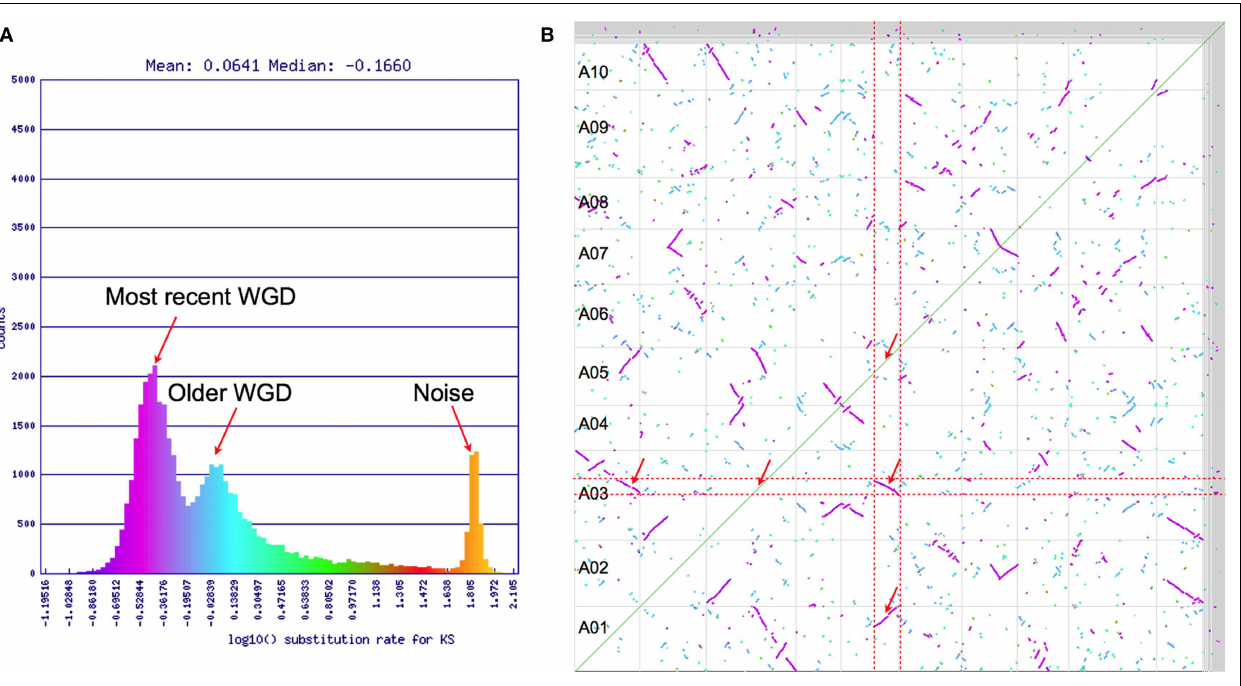
comparison with gene pairs colored by their K s values shown in ( A) . Results may be regenerated: